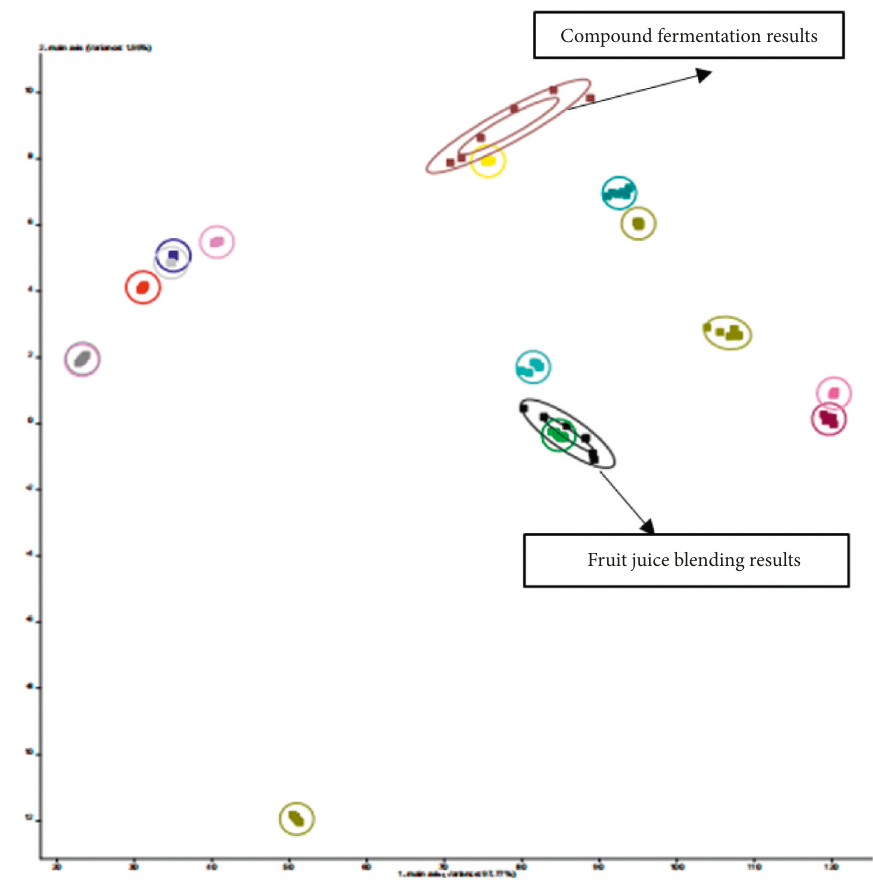
Figure 11: Electronic nose measurement